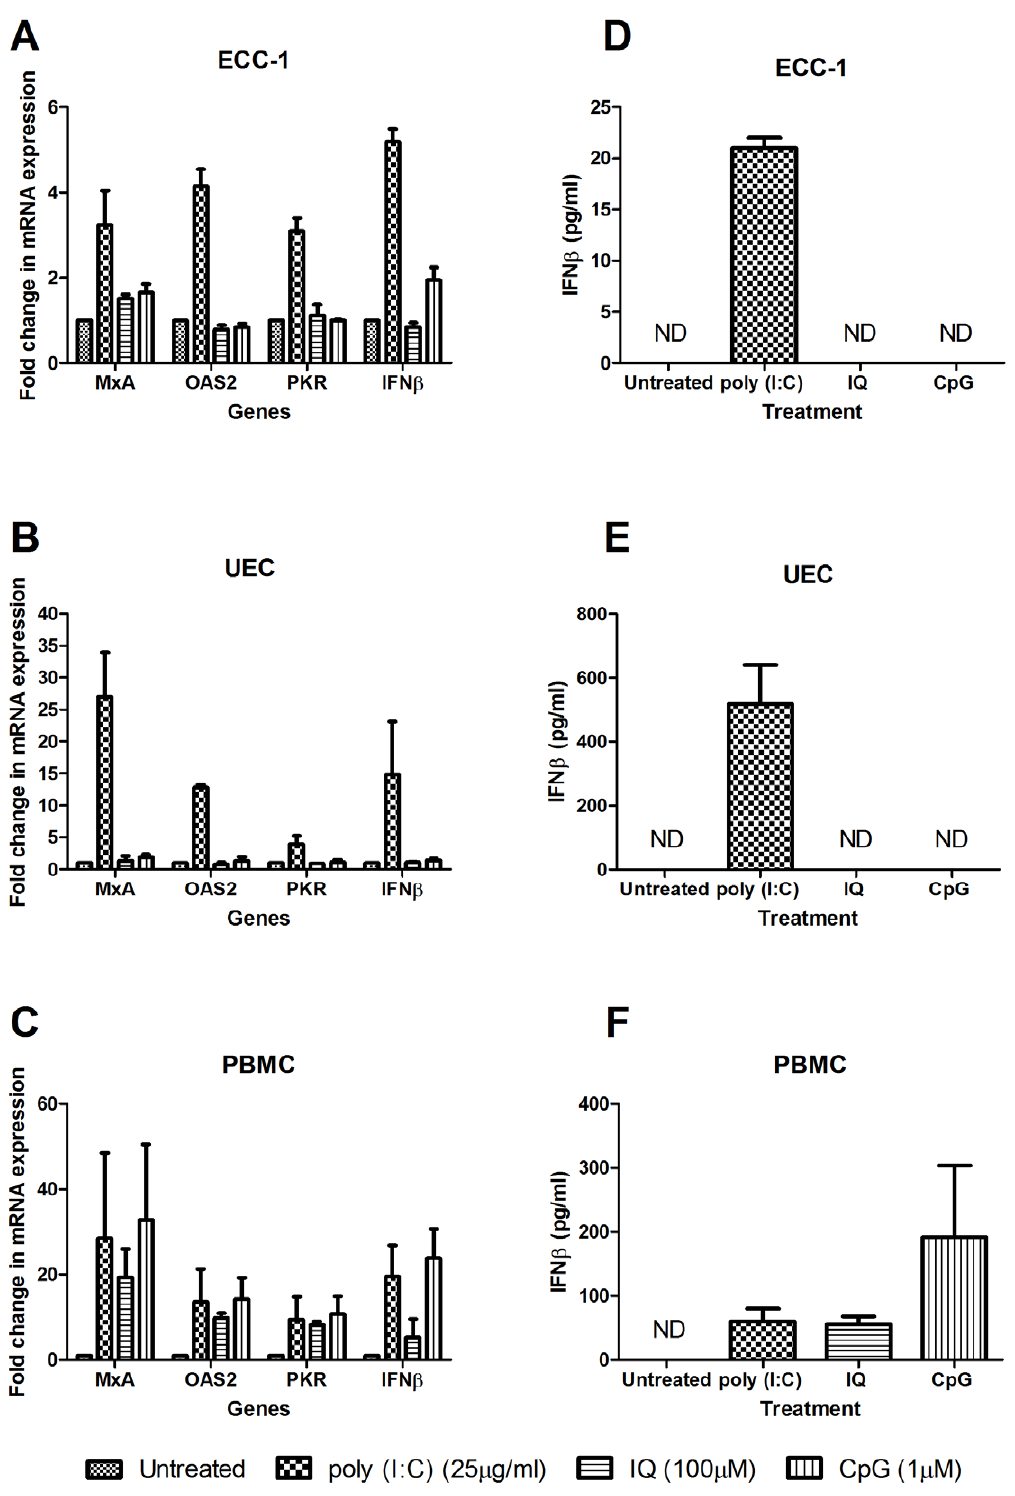
Figure 2. Epithelial cells induce IFN b and ISG gene expression in response to poly (I:C). ECC-1 ( n=3 ) (a & d), and primary human UEC ( n=3 ) (b & e) were cultured on cell inserts until confluent with a TER above 1000 ohms and then apically stimulated with poly (I:C) (25 m g/ml), IQ (100 m M) and CpG (1 m M) for 24 hours. The same treatment was applied to primary human PMBC cultured in a 24-well plate ( n=3 ) (c & f). Cell culture conditioned media was recovered and analyzed by ELISA for IFN b secretion (d, e & f). Concurrently total cellular mRNA was isolated and analyzed for changes in gene expression (a, b & c). mRNA is expressed as a fold change over untreated samples (assigned a value of 1). (ND=below detection limit of the ELISA assay).